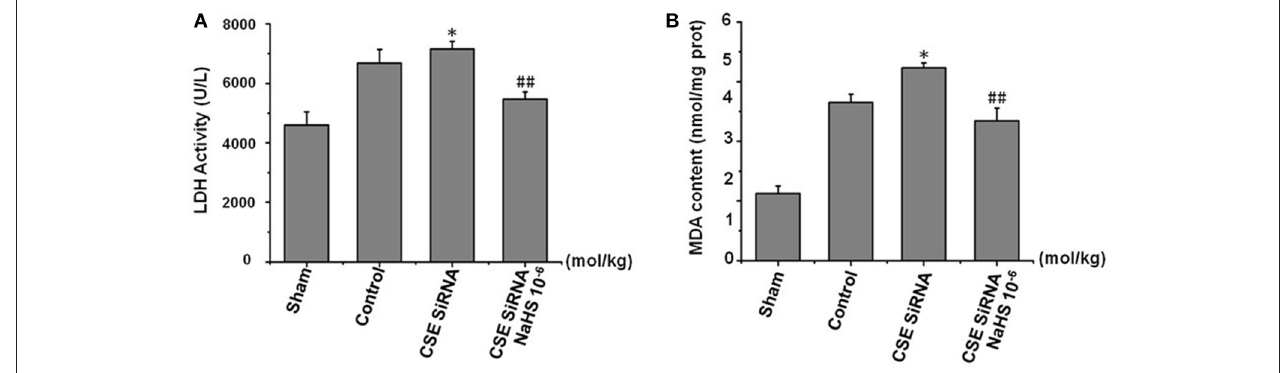
FIGURE 6 | Effect of CSE knockdown (CSE siRNA) on MCAO rat serum LDH activity and MDA content in brain tissue (mean ± SEM, n = 8). (A) Serum LDH activity. (B) MDA content in brain tissue. * P < 0.05 vs. control; ## P < 0.01 vs. CSE